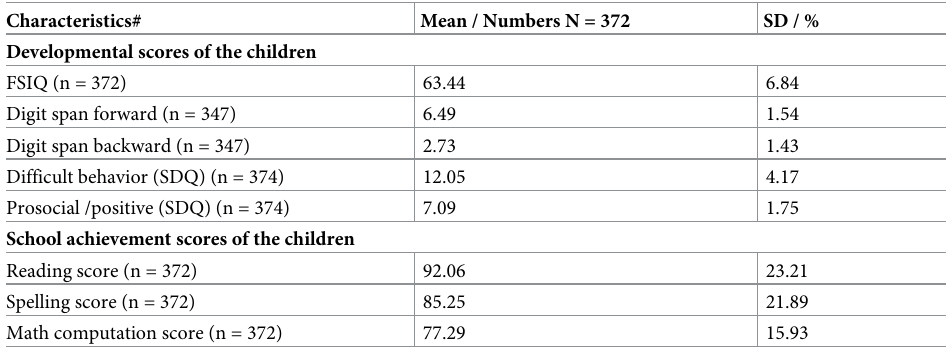
Table 1. Children’s developmental status and school performance scores (n =